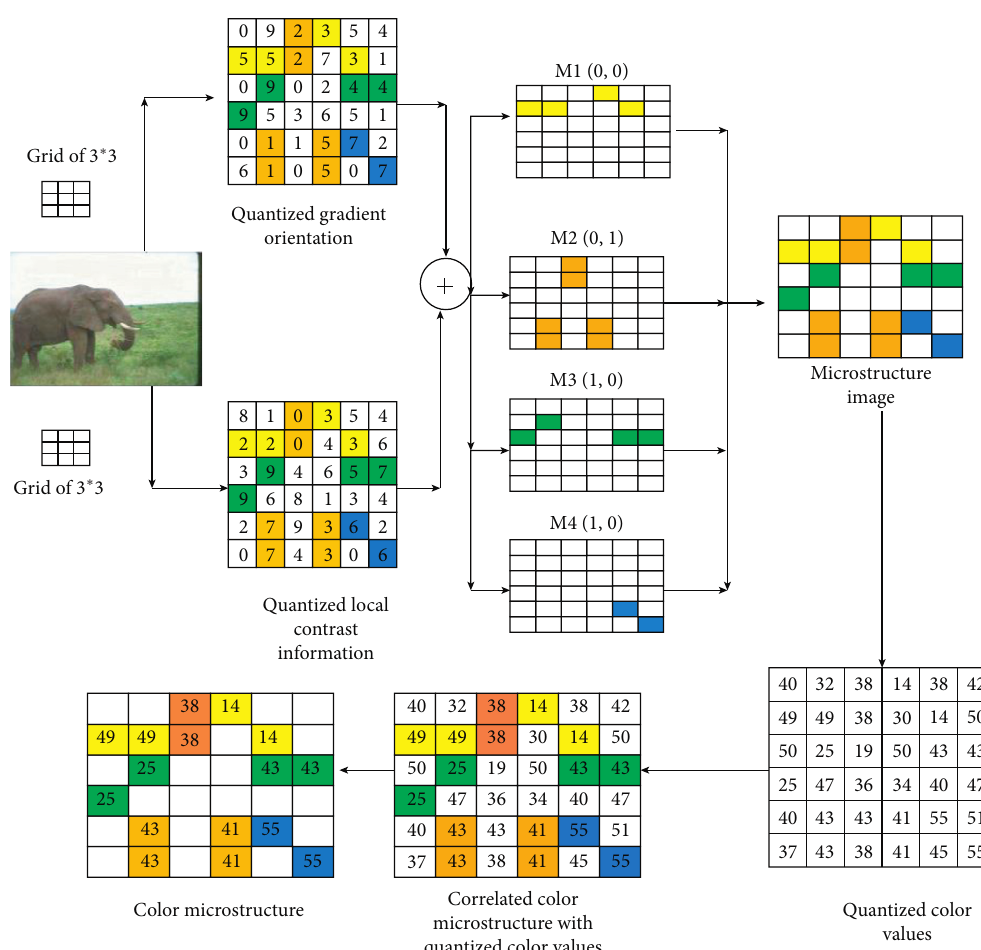
Figure 4: Correlated microstructure. It is formed by correlating the quantized color, orientation, and local contrast information quantized